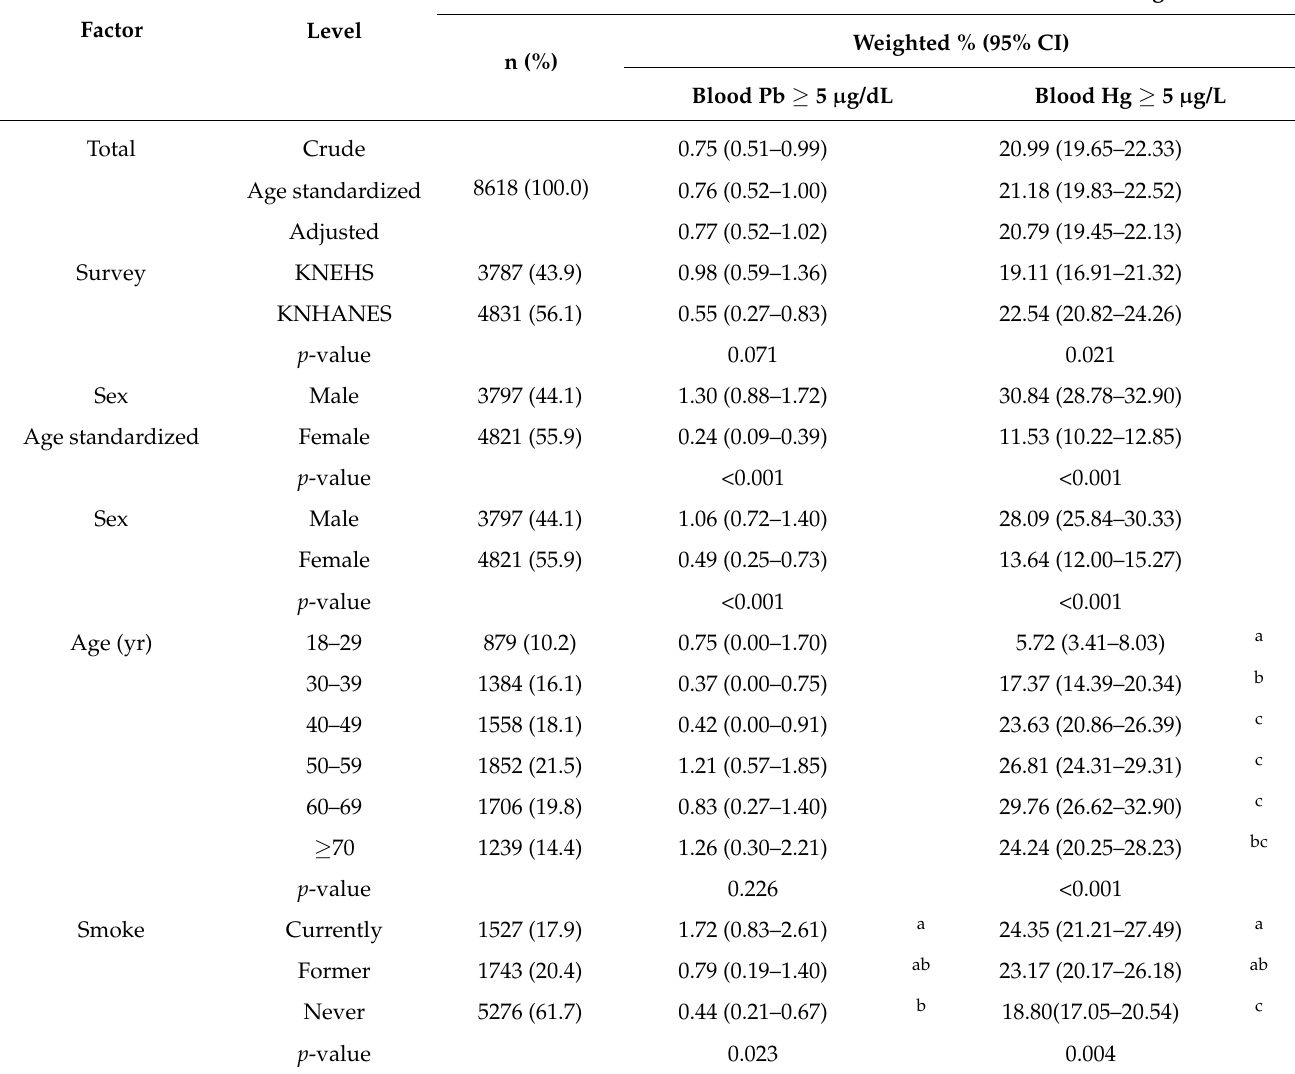
Table 3. Proportion above reference value of blood lead and mercury in integrated data recent survey.